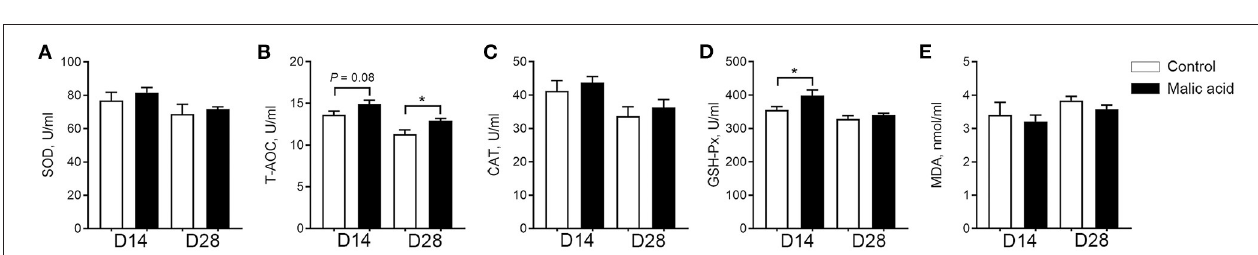
FIGURE 2 | Effects of dietary malic acid supplementation on skeletal muscle fiber-type transition in LT muscles of weaned piglets. (A,B) Effects of malic acid on the percentage of SDH positive fibers. (C) Effects of malic acid on mRNA levels of MyHCs , PGC1 α , Myoglobin, and Tnnts . (D) Reprehensive hematoxylin–eosin staining images of LT muscle. (E) Fiber average crosssectional area and (F) frequency histogram of fiber crosssectional area in (D) . Scale bars, 100 µ m for (A) and 50 µ m for (D) . Data are presented as means ± SEM ( n = 6). The statistical significance of difference between two means was calculated using t -test. * p < 0.05, ** p < 0.01.